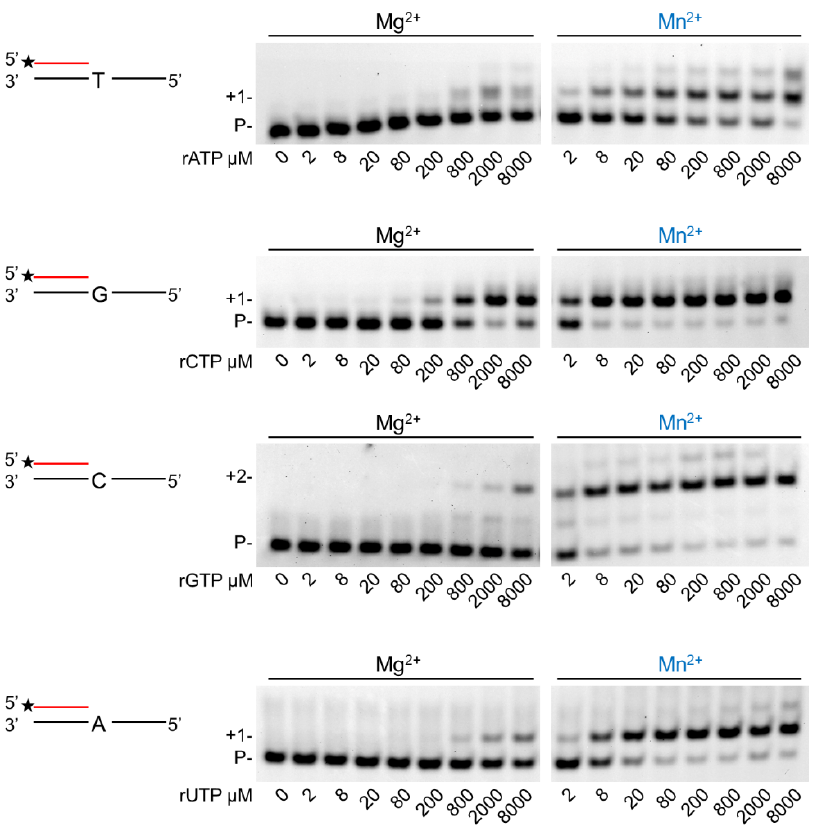
Figure 4. Manganese enhances hPol η ’s affinity to ribonucleotides. Reactions were performed using 1 nM enzyme, 20 nM RNA/DNA, 4 mM Mg 2+ or Mn 2+ , and various concentrations of individual rNTPs as indicated. Reaction time was 45 min. Labels are the same as in Figure 1. Table 1. Kinetic parameters of RNA extension with rNTPs by hPol η using Mg 2+ or Mn 2+ as cofactors.